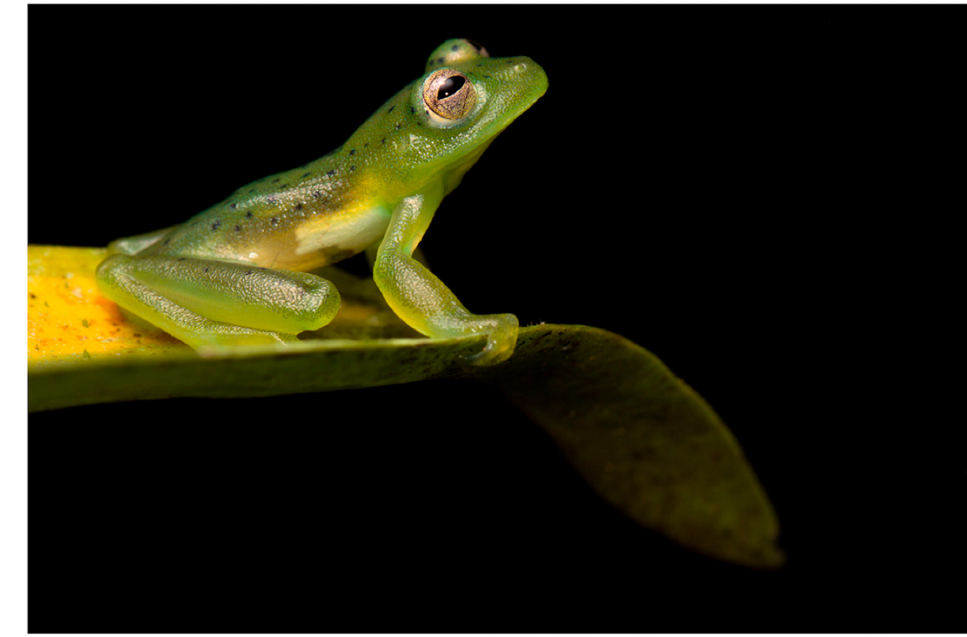
Figure 222. Vitreorana ritae from Yasuní National Park, Ecuador. Photo by Jaime Culebras.